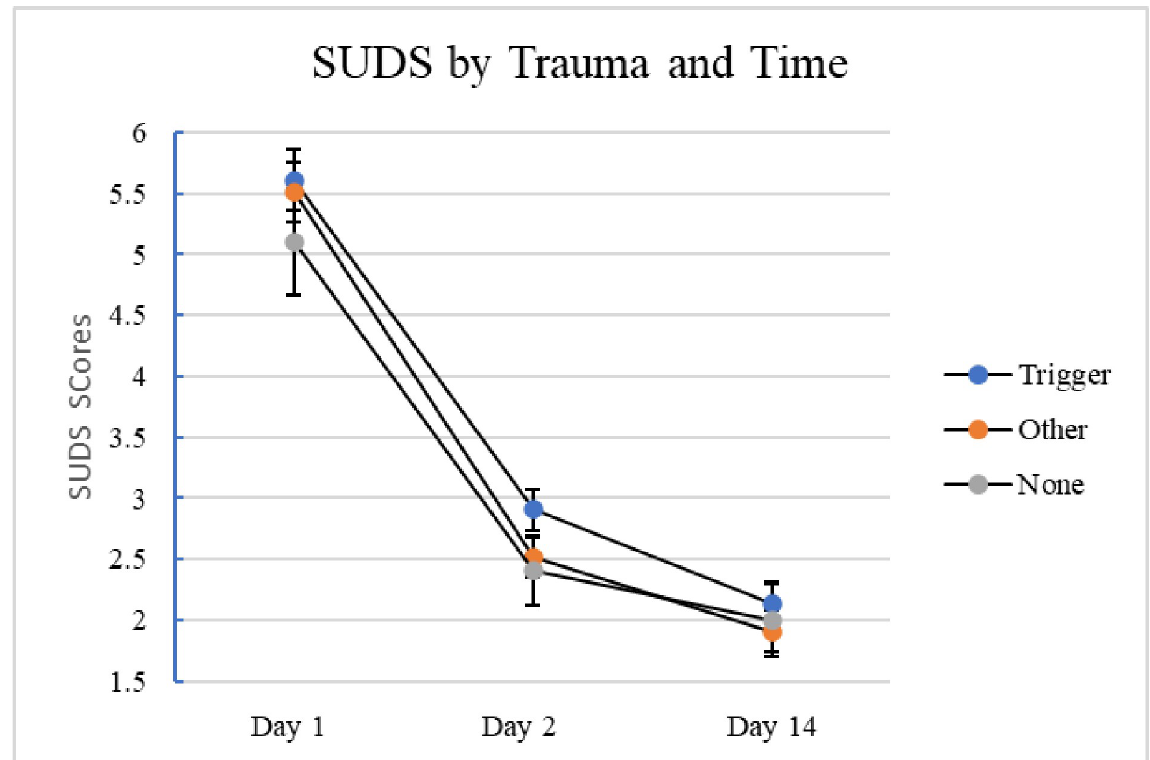
Fig 1. SUDS by trauma and time. Average subjective units distress shown with standard error bars as a function of day and trauma type (Trigger, n = 105; Other, n = 109, None, n = 34).